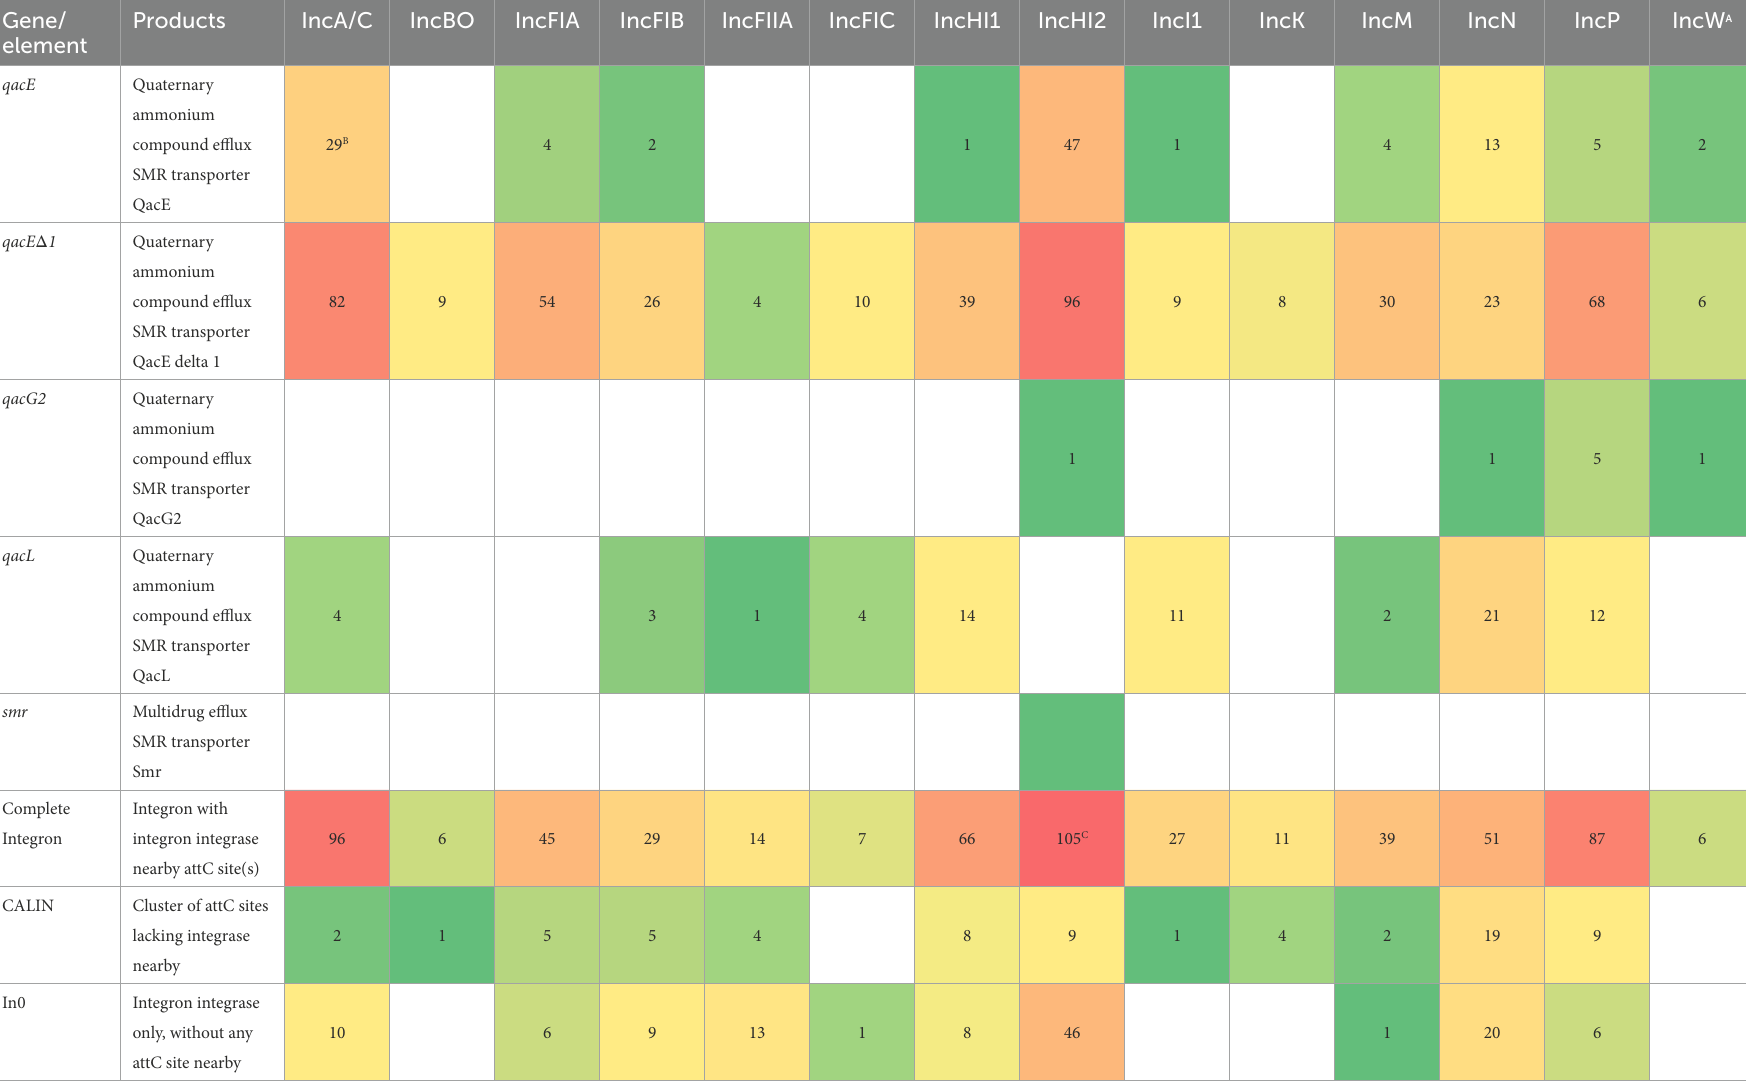
TABLE 2 Disinfectant and biocide resistance genes and integron-associated elements detected in 100 A representative sequences for each plasmid replicon type identified using AMRFinderPlus or IntegronFinder, respectively. Gene/